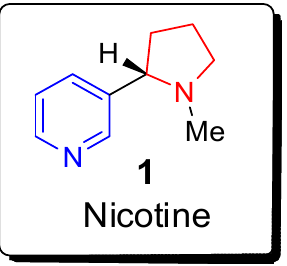
Figure 1. Chemical structure of nicotine ( 1 ), a chiral alkaloid consisting of two nitrogen heterocycles: a pyridine and a N -methylpyrrolidine moieties directly connected by a single carbon–carbon bond.